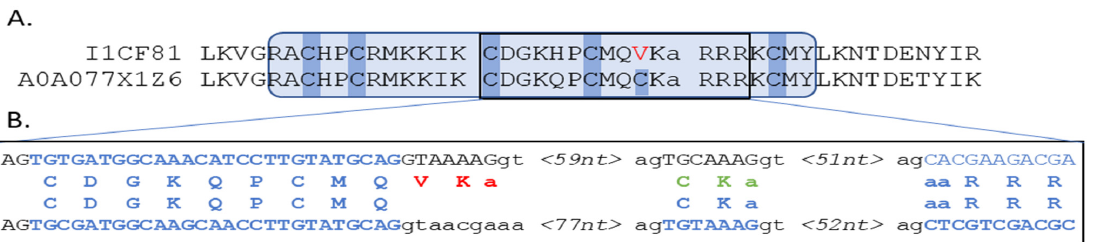
Figure 8. ( A ) Protein alignment of query I1CF81 with the neighbor A0A077X1Z6, showing the partial hit identified by the protocol, where the predicted sequence presents five of the six conserved cysteines that characterize the Zn2C6 DBD (hmmsearch E -value = 1.5 × 10 − 11 ). Exon/intron boundaries are indicated by gaps in the sequences. ( B ) Genome-level comparison of query I1CF81 with the neighbor A0A077X1Z6, showing correctly predicted amino acids (blue), protocol mispredicted amino acids (red), and alternative manual prediction